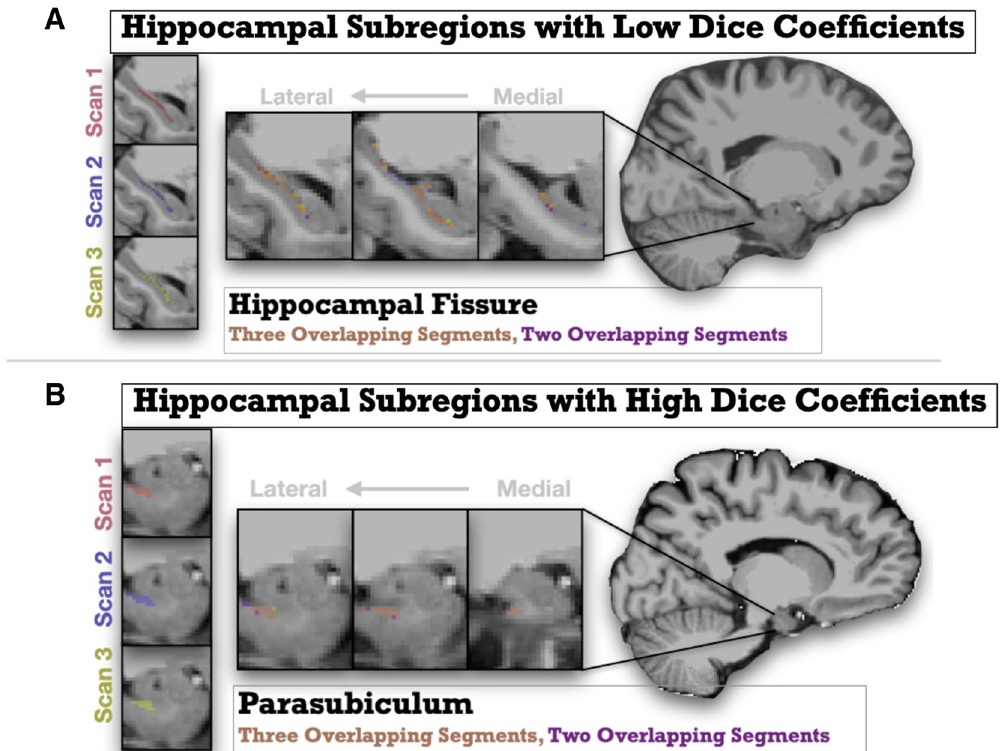
Fig. 3 Graphic representations showing magnified depictions of Hippocampal subregions with low and high Dice coefficients (i.e., spatial reliability) from repeated scans (Scan 1 shown in Red; Scan 2 shown in Purple, Scan 3 shown in Yellow). The anatomical (T1w) image underlaid is the unbiased subject template from an example participant. The top panel A represents the hippocampal fissure, an area with low spatial reliability across scans, and the bottom panel B represents the parsubiculum, and area with high spatial reliability. Slices move right to left from medial to